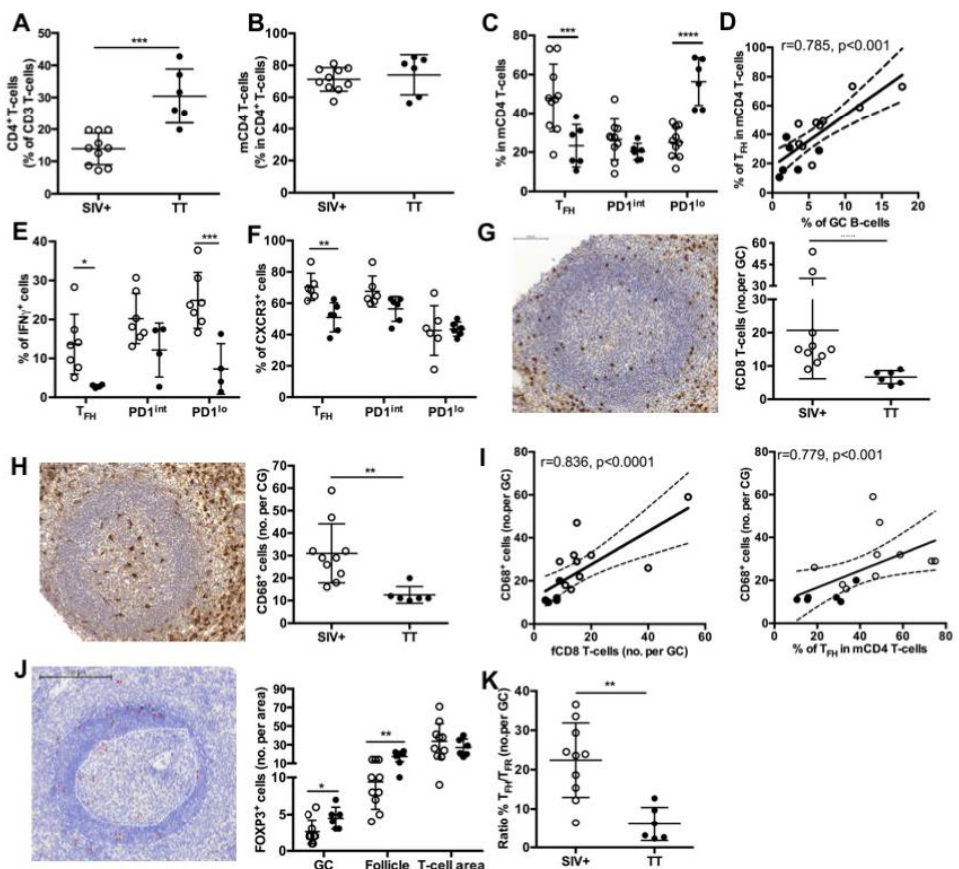
Figure 5. Splenic T-cell subsets in SIV-infected and TT- vaccinated macaques. Proportions of ( A ) CD4 + T-cells in total T-cells and ( B ) mCD4 T-cells in CD4 + T-cells are shown. ( C ) Proportions of T FH , PD1 int and PD1 lo subsets for each macaque are shown. Statistical comparison between groups was performed using 2-way ANOVA with Bonferroni’s multiple comparisons test. Statistically significant values are indicated: *** p < 0.001, **** p < 0.0001. ( D ) Correlation between the percentages of GC B-cells and T FH is shown. Spearman rank test was used for statistical analyses. rho and p values are given. ( E ) Proportions of IFN γ + cells in every mCD4 T-cells are plotted for each macaque. Seven and four macaques have been tested for the Group SIV + and TT, respectively. Statistical comparison between groups was performed using 2-way ANOVA with Bonferroni’s multiple comparisons test. Statistically significant values are indicated: * p < 0.05 and *** p < 0.001. ( F ) Proportions of CXCR3 + cells in every mCD4 T-cell subset are plotted for each macaque. Six macaques have been tested for each group. Statistical comparison between groups was performed using 2-way ANOVA with Bonferroni’s multiple comparisons test. Statistically significant values are indicated: ** p < 0.01. Representative staining with ( G ) CD8 and ( H ) CD68 Abs of spleen sections from one macaque of the TT group is shown in left panels. Mean numbers of positive cells per GC are plotted for each macaque (right panels). Scale Bar = 100 µ m ( I ) Graph represents the correlation between the number of CD68 + cells per GC and either the number of fCD8 per GC (left panel) or the percentages of T FH (right panel). Spearman rank test was used for statistical analyses. rho and p values are given. Each dot represents mean value for one macaque from the SIV + ( open circle ) or TT ( black circle ) group. ( J ) Representative staining with FOXP3 Ab of spleen sections from one macaque of the TT group is shown in left panel. GC and mantle zone are fixed by white dotted lines and FOXP3 + cells are indicated by red asterisks. Proportions of FOXP3 + cells in GC, follicle and T-cell area are plotted for each macaque. Scale Bar = 200 µ m. ( K ) Ratio between numbers of T FH and T FR per GC was plotted for each macaque from Groups SIV + and TT. Statistical comparison between groups was performed using 2-way ANOVA with Bonferroni’s multiple comparisons test. Statistically significant values are indicated: * p < 0.05 and ** p < 0.01. For ( A , B , G , H , K ), bars represent Mean values of the group ± SD and statistical comparison between groups was performed using the Mann Whitney non-parametric test. Statistically significant values are indicated: ** p < 0.01 and *** p < 0.001